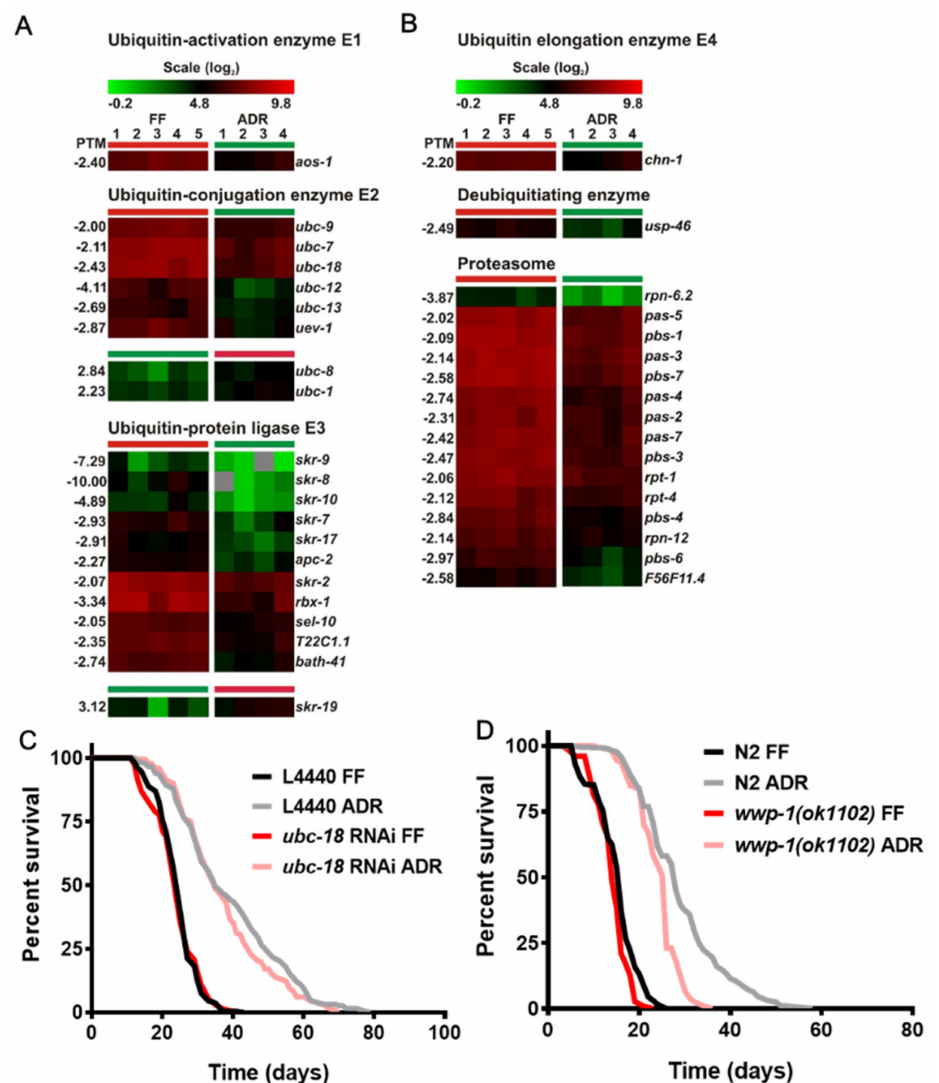
Figure 3. Down-regulated genes of the ubiquitin proteasome system. ( A ) General down-regulation of genes coding for ubiquitin activation enzyme E1, ubiquitin conjugation enzyme E2, and ubiquitin- protein ligase E3. ( B ) General down-regulation of genes in ubiquitin elongation enzyme E4, deubiqui- tinating enzyme, and proteasomal subunits. Survival analysis of ubc-18 RNAi ( C ) and wwp-1 mutants ( D ). L4440 = empty RNAi vector, FF = fully fed, ADR = axenic dietary